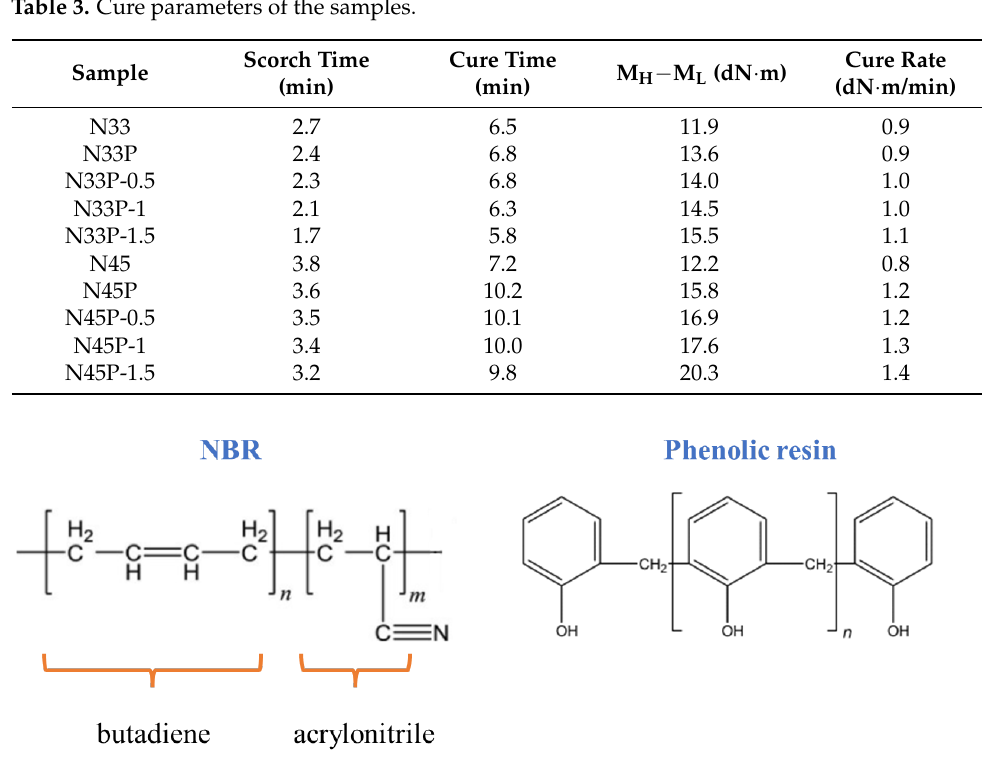
Figure 1. Chemical structure of NBR and phenolic resin .